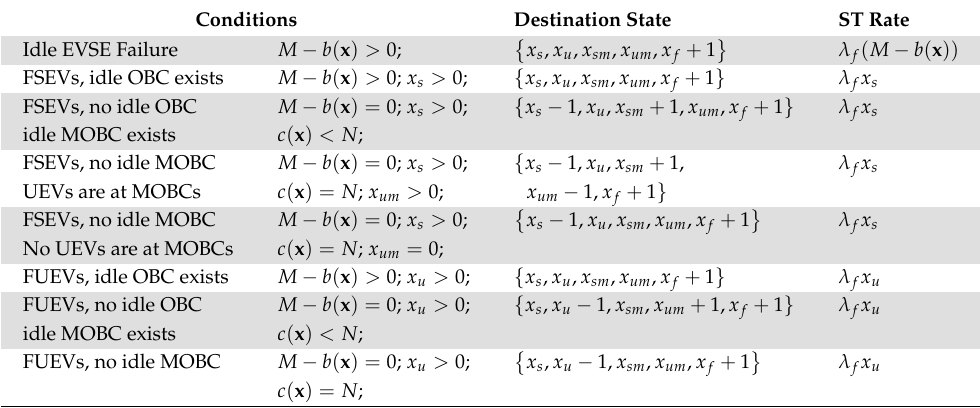
Table 4. STs from x triggered by EVSE failures and